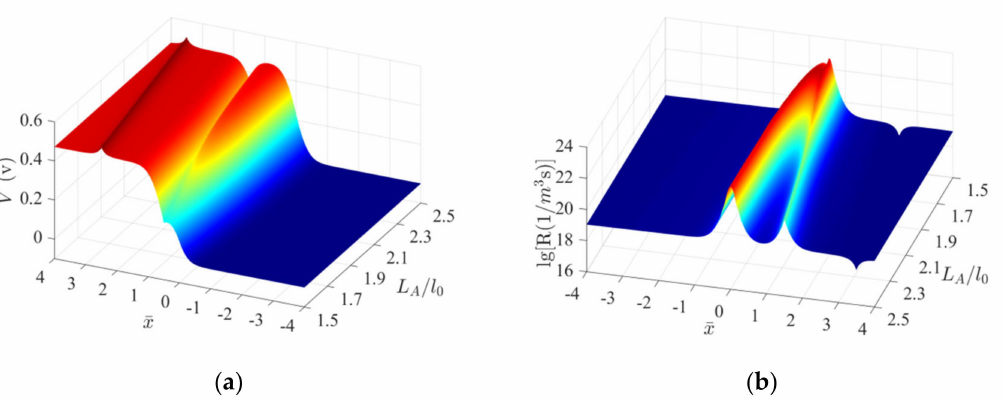
Figure 8. Evolution characteristics of the important physical quantities characterizing a ZnO PN junction subjected to a compressive-mode MIAPB under conditions of ∆ l = 1.0 l 0 . ( a ) Electric potential configurations and ( b ) recombination